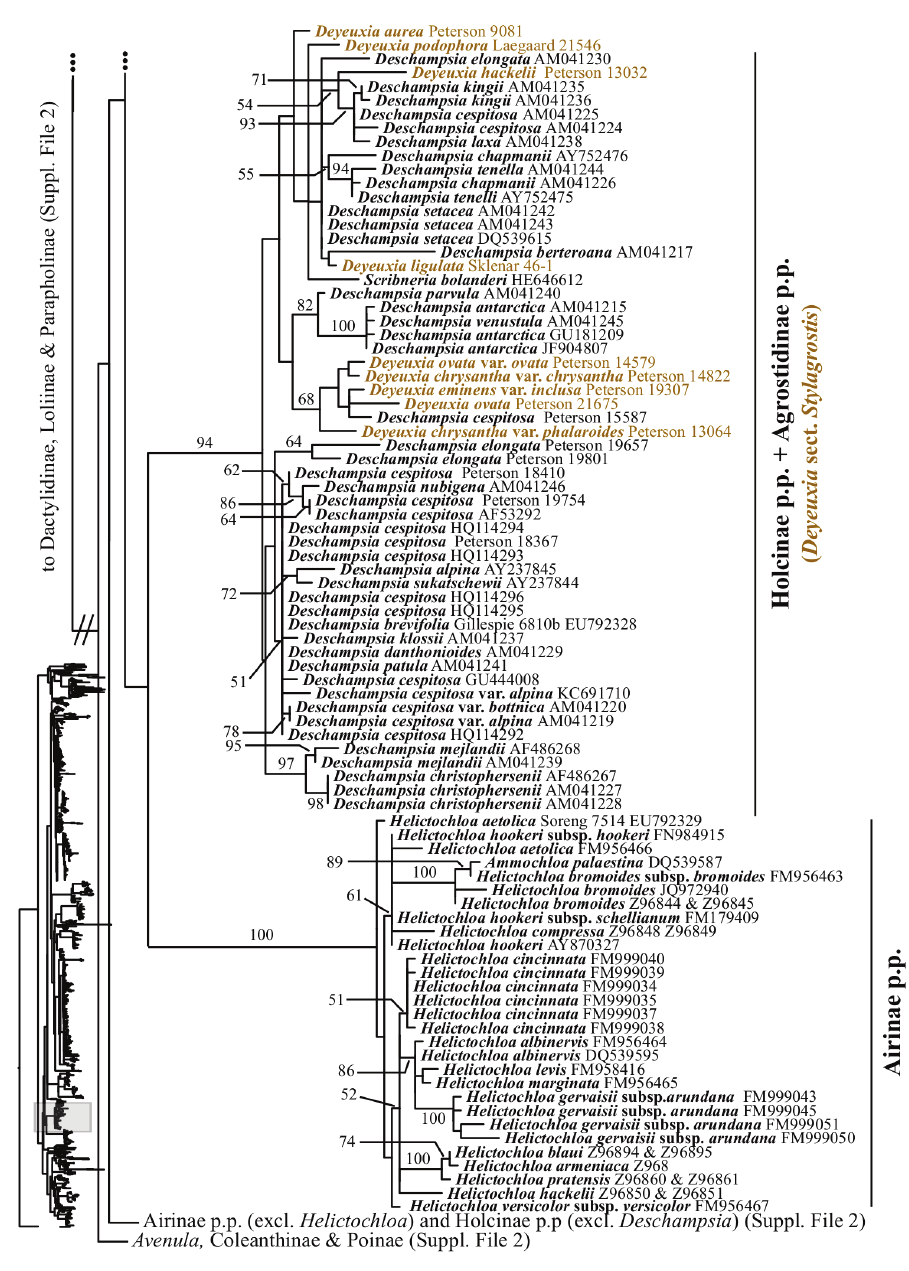
Figure 18. A portion (Agrostidinae p.p., Holcinae p.p. and Airinae p.p.) of the maximum likelihood phylogram inferred from ITS data. ML bootstrap support is recorded along branches when >50%. The shaded area of the smaller tree on the bottom left indicates the location in the overall tree of the portion shown. Backbone branches represented by ellipses are shown only in Fig.